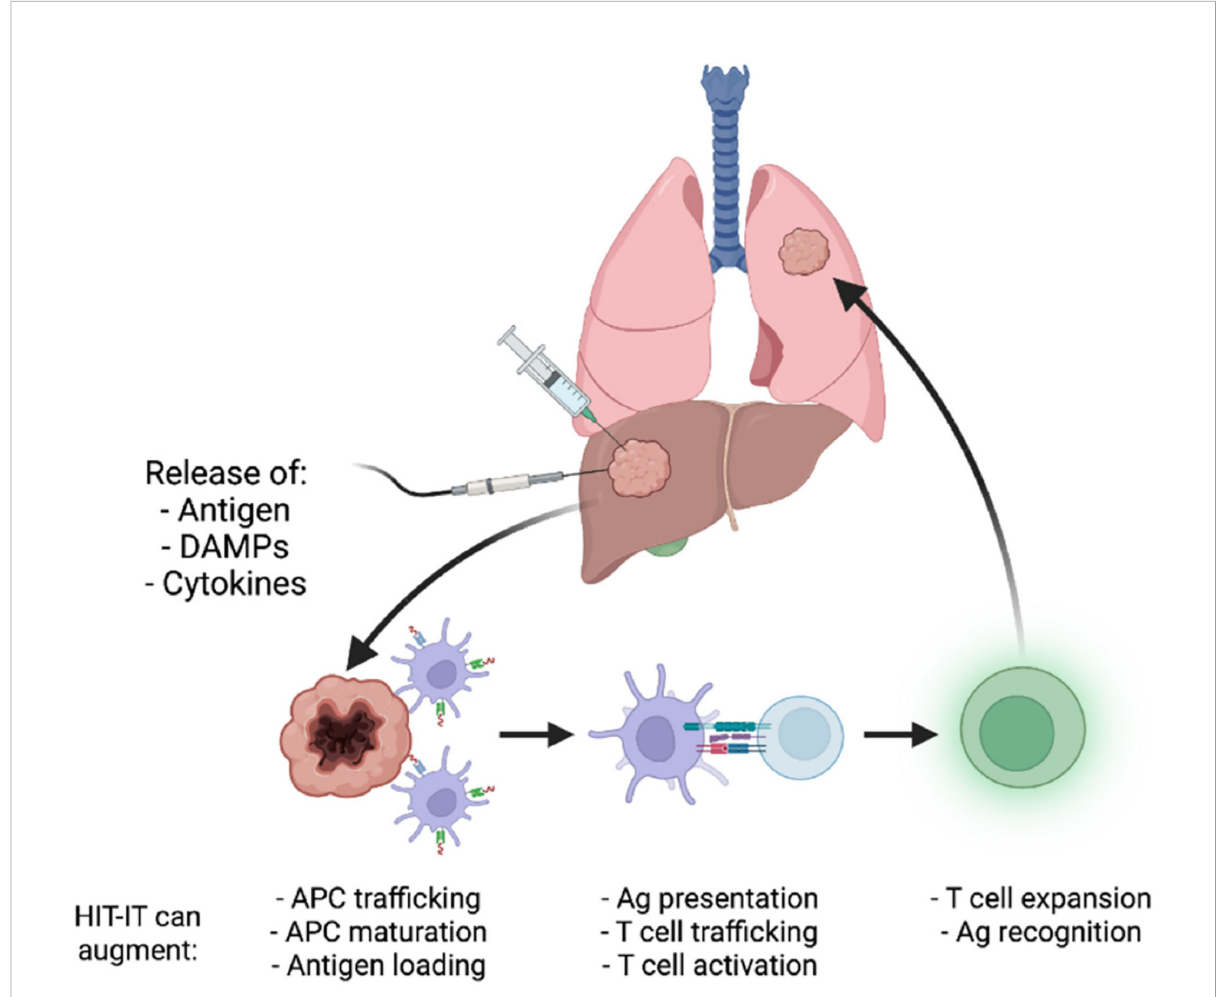
FIGURE 1 Illustration of the mechanism underlying intratumoral cancer immunotherapy. Reproduced without change from Senders et. al. (17) (HIT-IT = human intratumoral immunotherapy, Ag,